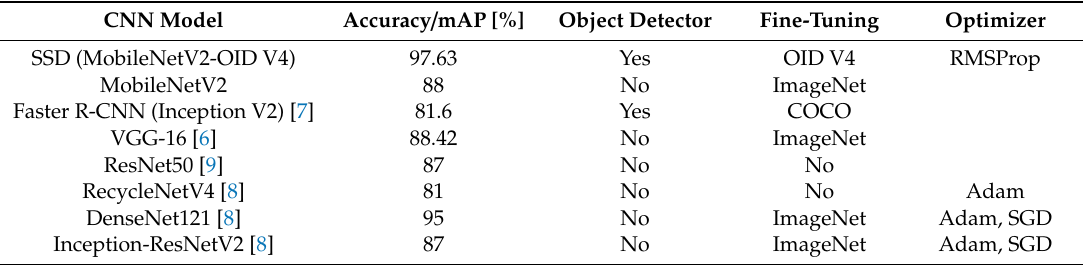
Table 5. Evaluation with other trained or fine-tuned model on the TrashNet